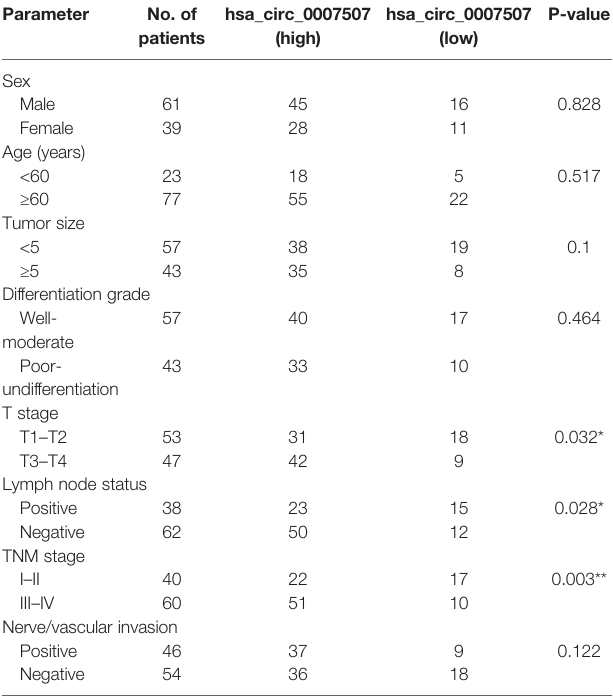
TABLE 2 | The association between hsa_circ_0007507 expression and the clinicopathological parameters in GC patients.